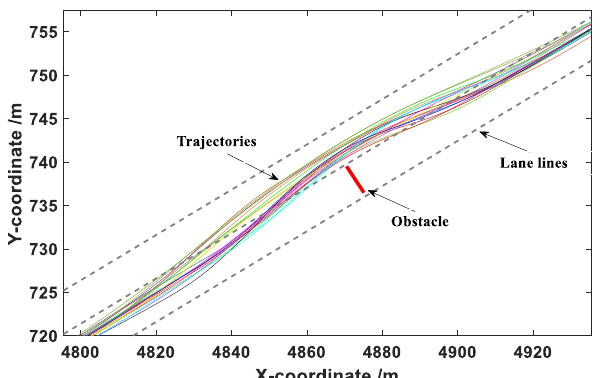
Figure 9. Obstacle avoidance trajectories under a vehicle speed of 40 km/h.